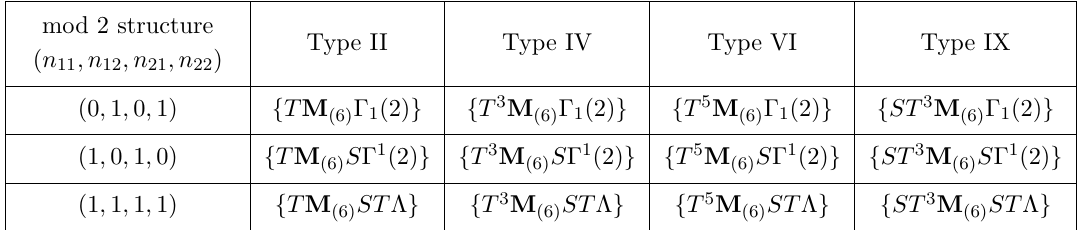
Table 17 . Classification of Types II, IV, VI, IX for D = 6 .